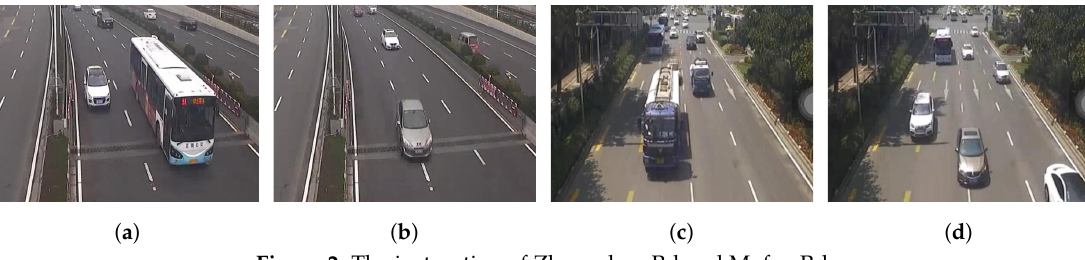
Figure 2. The instruction of Zhongshan Rd and Mofan Rd.